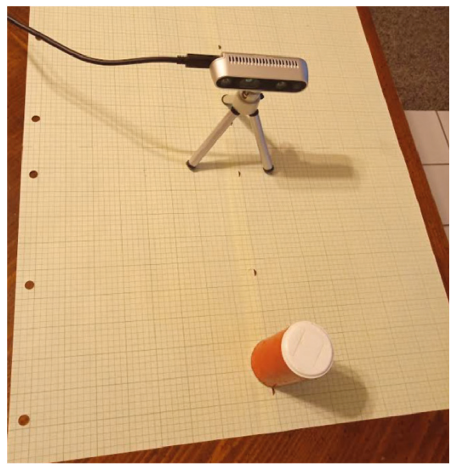
Figure 24: Camera moved based on inverse